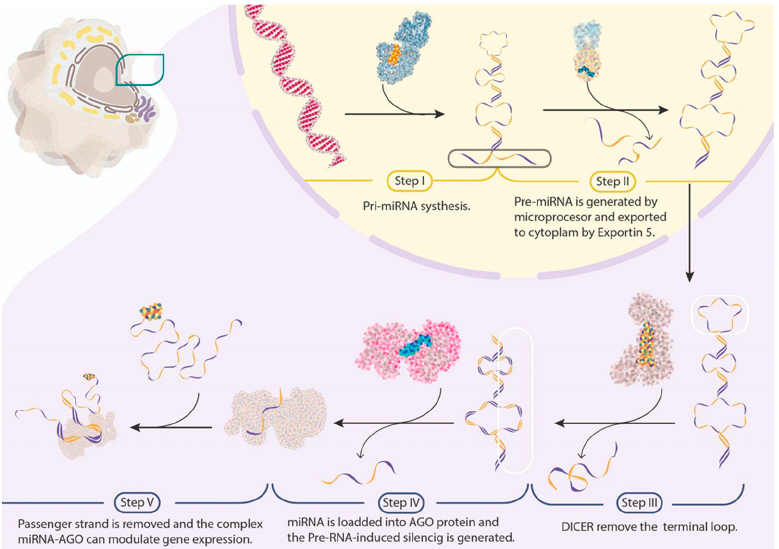
Figure 1. Canonical miRNA biogenesis. Schematic representation of the canonical pathway in miRNA generation, with the active sites proteins represented with different colours. We frame the RNA fragments that are processed in each part of the process.